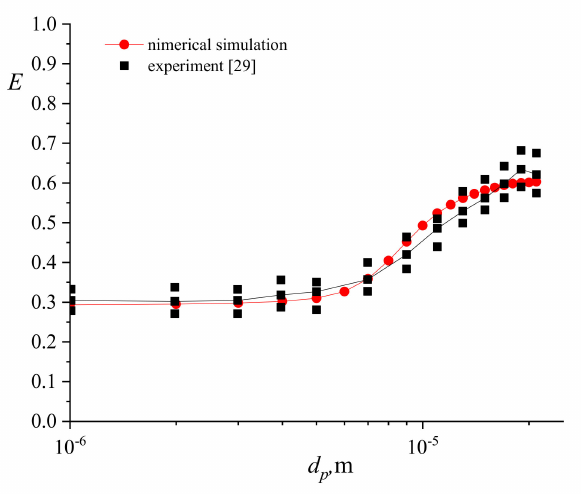
Figure 5. Comparison of the filtration efficiency of a granular filter with the experimental data